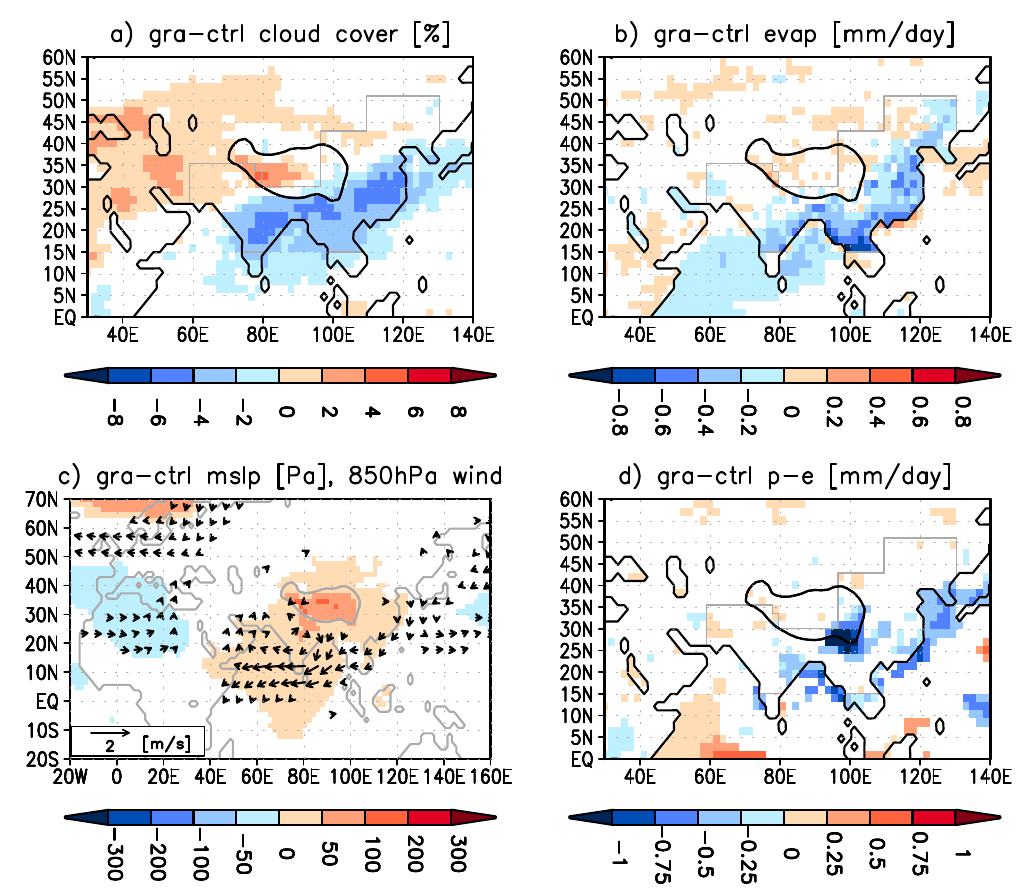
Fig. 7. Simulated change of different parameters influencing the precipitation change between the deforestation experiment (gra) and the control run (ctrl), averaged over the monsoon season. For further details see Fig. 5. Limit for wind-magnitude to be shown: 0.2ms − 1